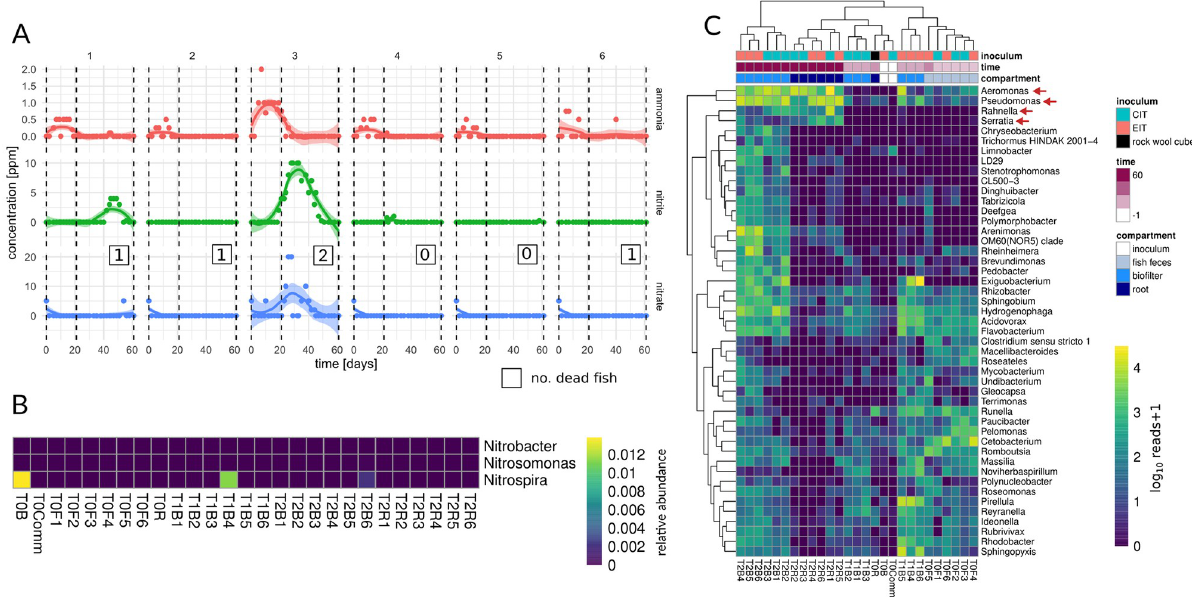
Fig 2. Nitrogen cycling and microbial composition. (A) Shown are measurements for ammonia, nitrite and nitrate throughout the experiment. Colored lines denote smooth fit from a LOESS regression and filled areas denote 95% confidence intervals of the regression. Numbers of the panels denote tanks. Tanks 1–3 are CIT whereas tanks 4–6 are EIT. Dashed lines denote the three time points used for microbiome sampling. Boxed numbers denote the number of fish that died in the tank. (B) Relative abundance (fraction of total reads per sample) of known nitrifying taxa. (C) Abundances of ubiquitous bacterial genera across the samples (present in at least 2 samples at an abundance > 300 reads). Colors of cells denote the normalized abundance on a base 10 log-scale. Sample names are composed of sampling group ID (e.g. T1), compartment (B = biofilter, F = fish feces, R = root, Comm = commercial inoculum) and tank number (1–6). Orange arrows denote genera of interest. Black fill color denotes initial root sample from rock wool cubes (not part of inoculation strategy).